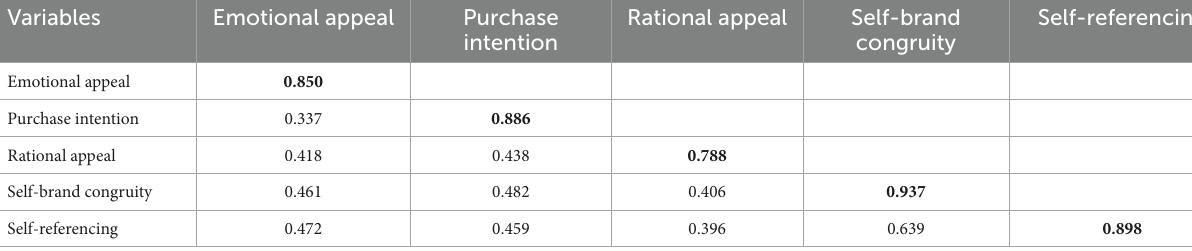
TABLE 4 Fornell–Larcker criterion (comparison of square root of average variance extracted and inter-construct correlations). Variables